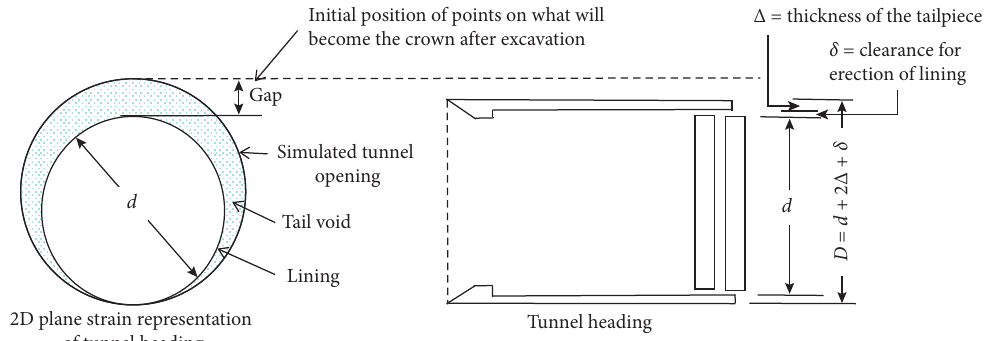
Figure 2: Gap of the shield tail (after Lee and Rowe